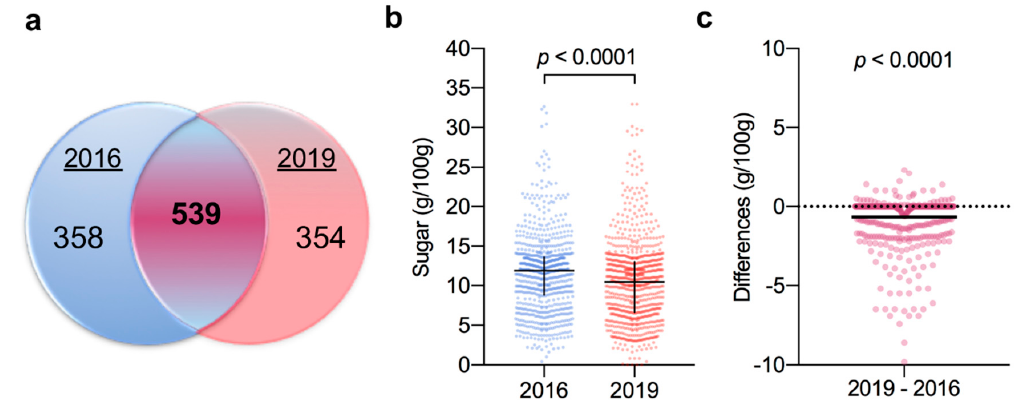
Figure 1. Comparison of total sugar content in yogurt products sold in 2016 and 2019. ( a ) Analysis of product names and brands identifies 539 products sold in both years. ( b ) Distribution of sugar content of all products from 2016 ( n = 898) and 2019 ( n = 893). Data were analysed using the Mann–Whitney test; black cross indicates median and interquartile range. ( c ) Di ff erence plot of the change in sugar content between the products sold both in 2019 and 2016 ( n = 539). Data were analysed using the Wilcoxon matched-pairs signed-rank test; solid black line indicates mean change ( − 0.6113) between 2016 and